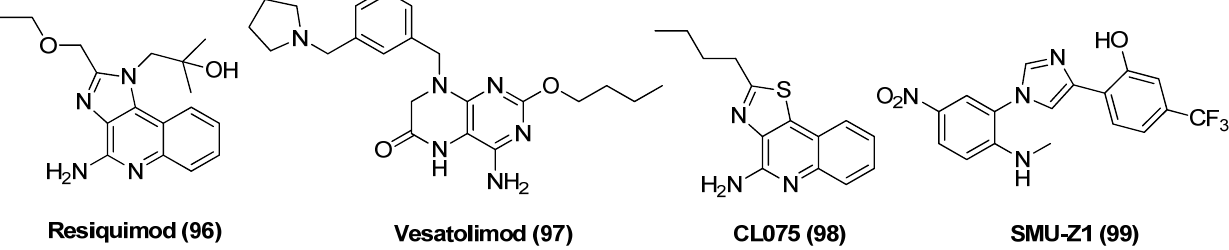
Figure 21. Chemical structures of TLR agonists 96~99 as LRAs. Considering that some TLR signaling, particularly TLR3, are distributed in microglia cells, which constitute the major HIV-1 reservoir in the brain, Karn and co-workers